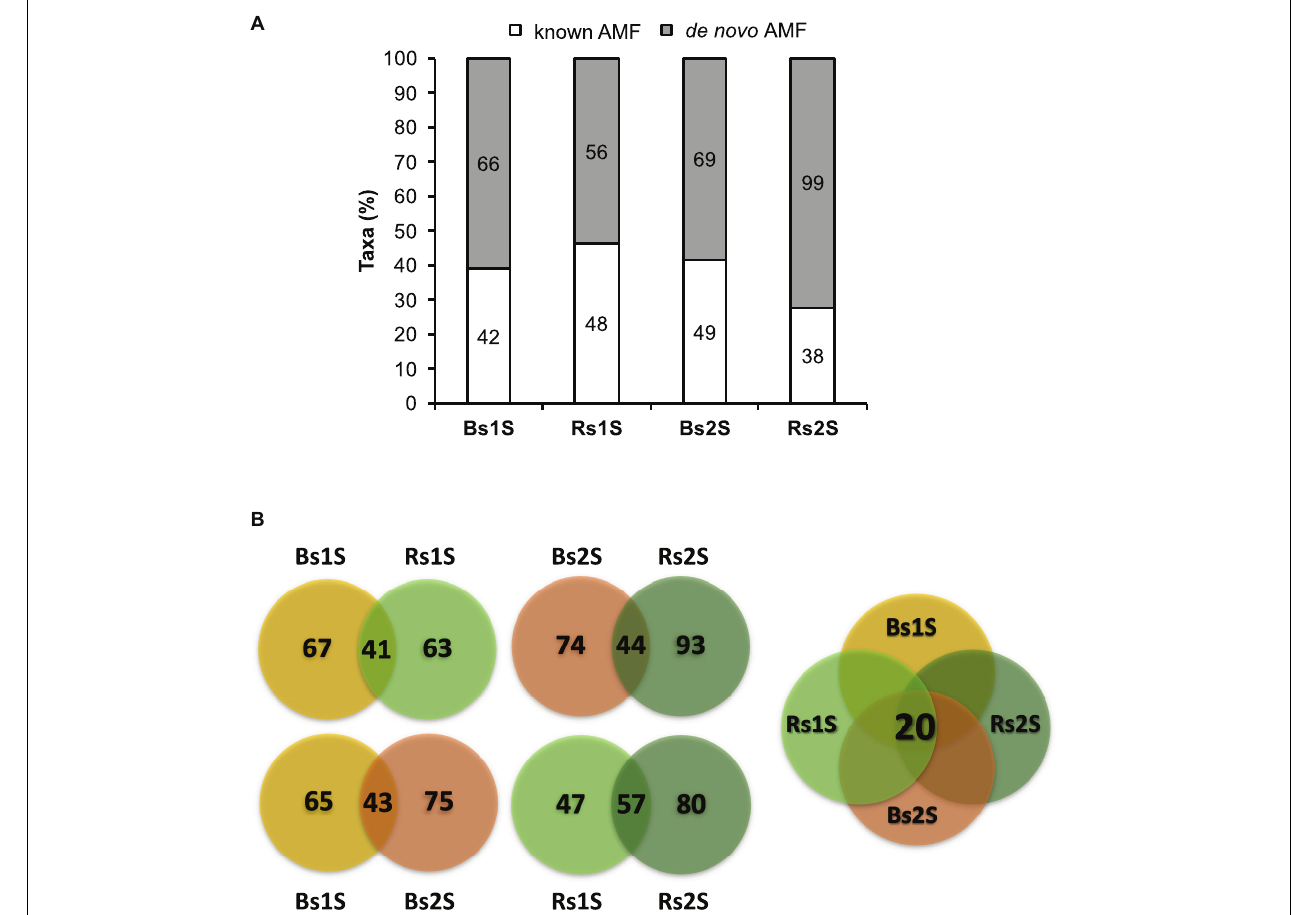
FIGURE 2 | (A) Abundance of the taxa obtained from the soils associated (Rs) or not (Bs) with the roots of Vitis vinifera cv. Pinot Noir during the two sampling times (1S = flowering and 2S = fruit development). Bars represent the percentage of known (white) or de novo (gray) arbuscular mycorrhizal fungi taxa, while labels inside the bars indicate the actual number of taxa. (B) Venn diagrams showing the number of taxa that were exclusive or common to (a) Bs and Rs soils in the first (1S) or in the second (2S) sampling time (upper part on the left of the figure), (b) the first (1S) and the second (2S) sampling times in Bs or in Rs (lower part on the left of the figure), and (c) the four soil samples (Bs1S, Rs1S, Bs2S, and Rs2S—on the right of the figure). The Venn diagrams were calculated by the freely available Venny version 2.1 software